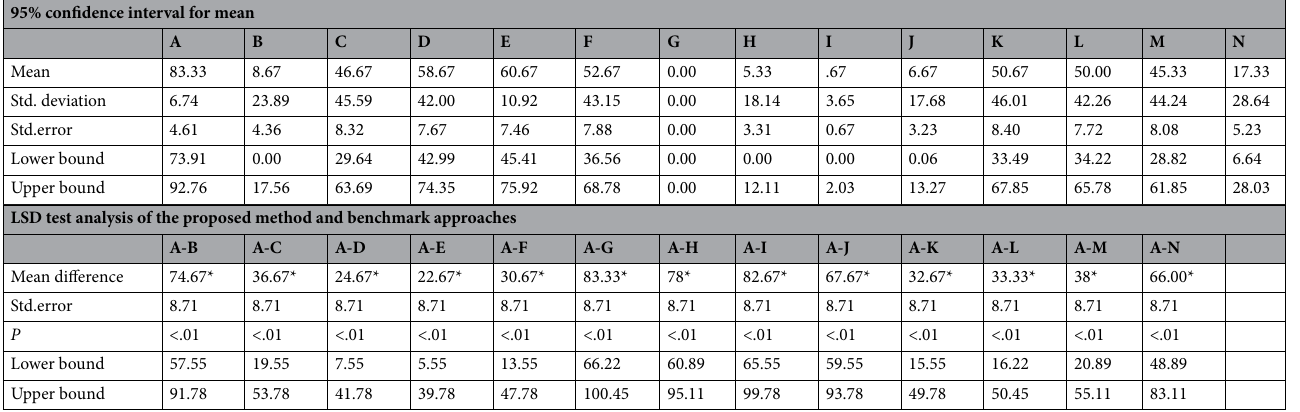
Table 2. Quantitative evaluation results on the triple staining prostate cancer dataset. Methods: (A) Proposed method, (B) CwR 10 , (C) bUnwarpJ-affine 7 , (D) bUnwarpJ-rigid 7 , (E) bUnwarpJ-similarity 7 , (F)